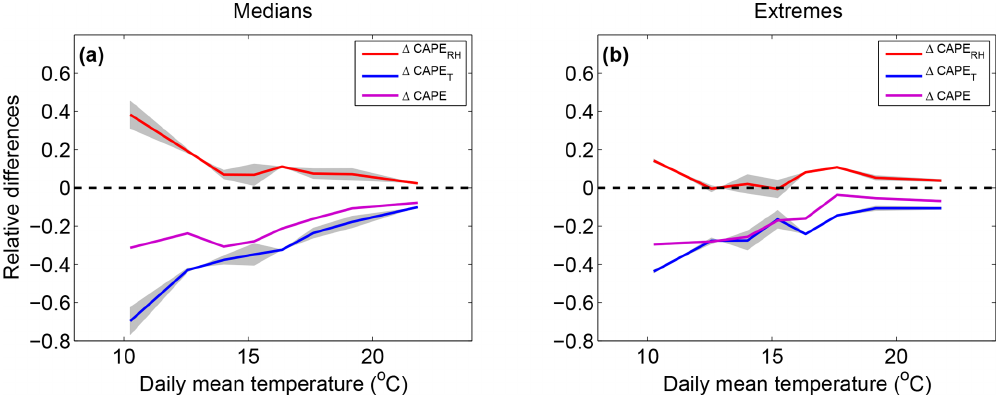
Figure 9. Relative differences in CAPE between the LR MAX and the LR MIN simulations for median (a) and extreme (b) convective precipitation events (magenta, (cid:49) CAPE). The temperature contribution ( (cid:49) CAPE T ) is displayed in blue and the relative humidity contribution ( (cid:49) CAPE RH ) in